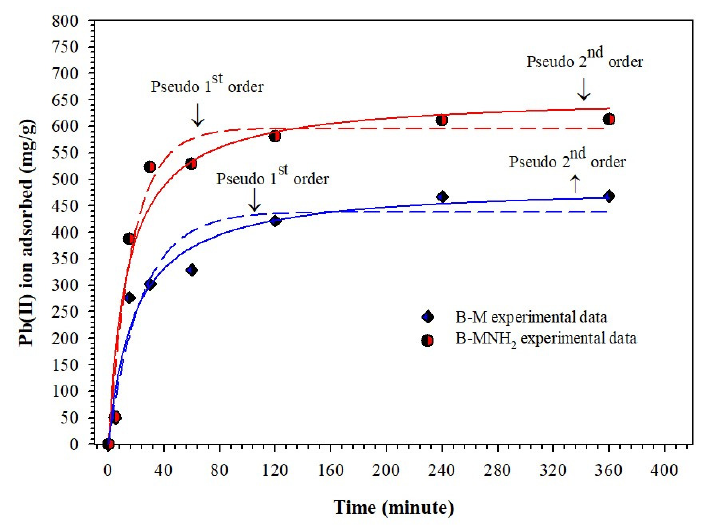
Figure 5. Kinetic Pb(II) ion adsorption by B-M and B-MNH 2 at different contact times. Reaction conditions: an initial Pb(II) ion concentration of 100 mg L − 1 , an adsorbent mass of 60 mg, a sample volume of 200 mL, a pH of 5, and a shaking rate of 150 rpm.